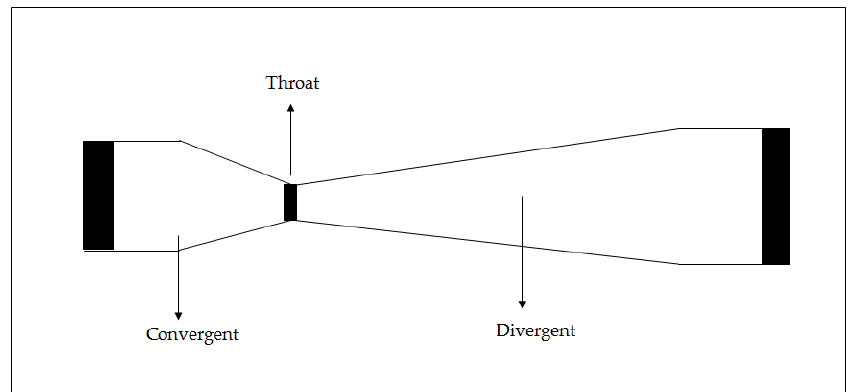
Figure 4. Schematic representation of venturi.